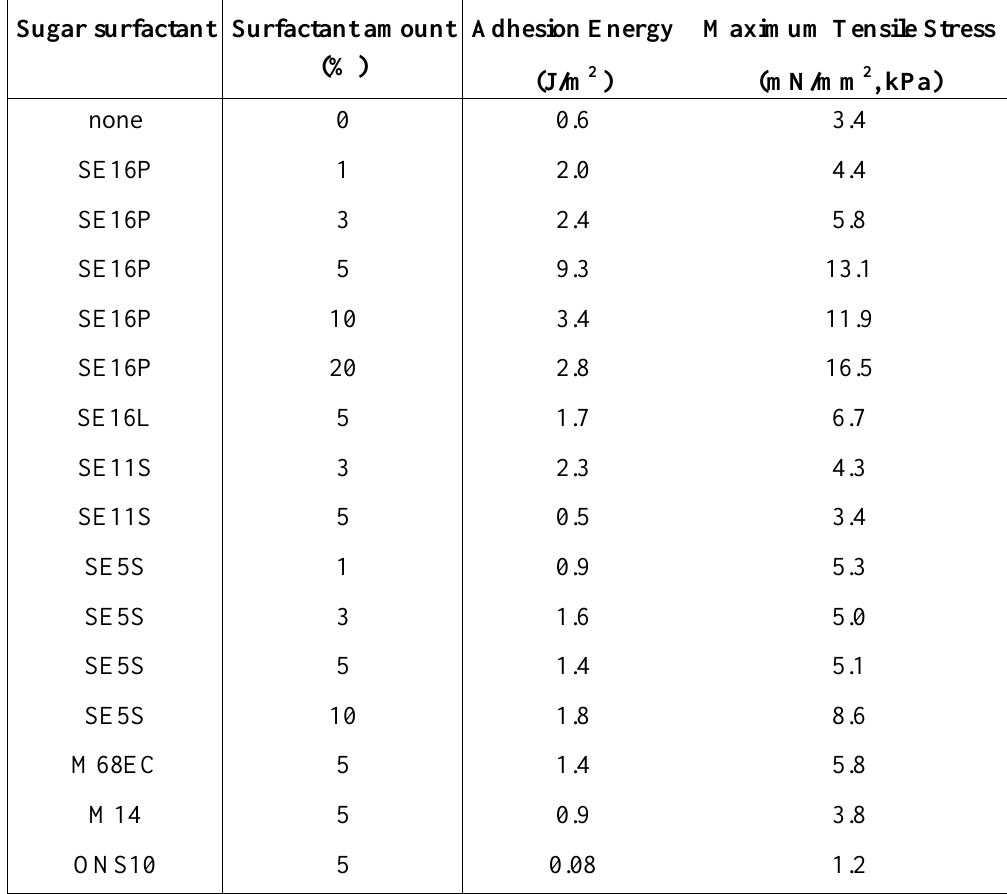
Table 2. Adhesion energy to nylon and maximum tensile stress of cement pastes with the different sugar surfactants.